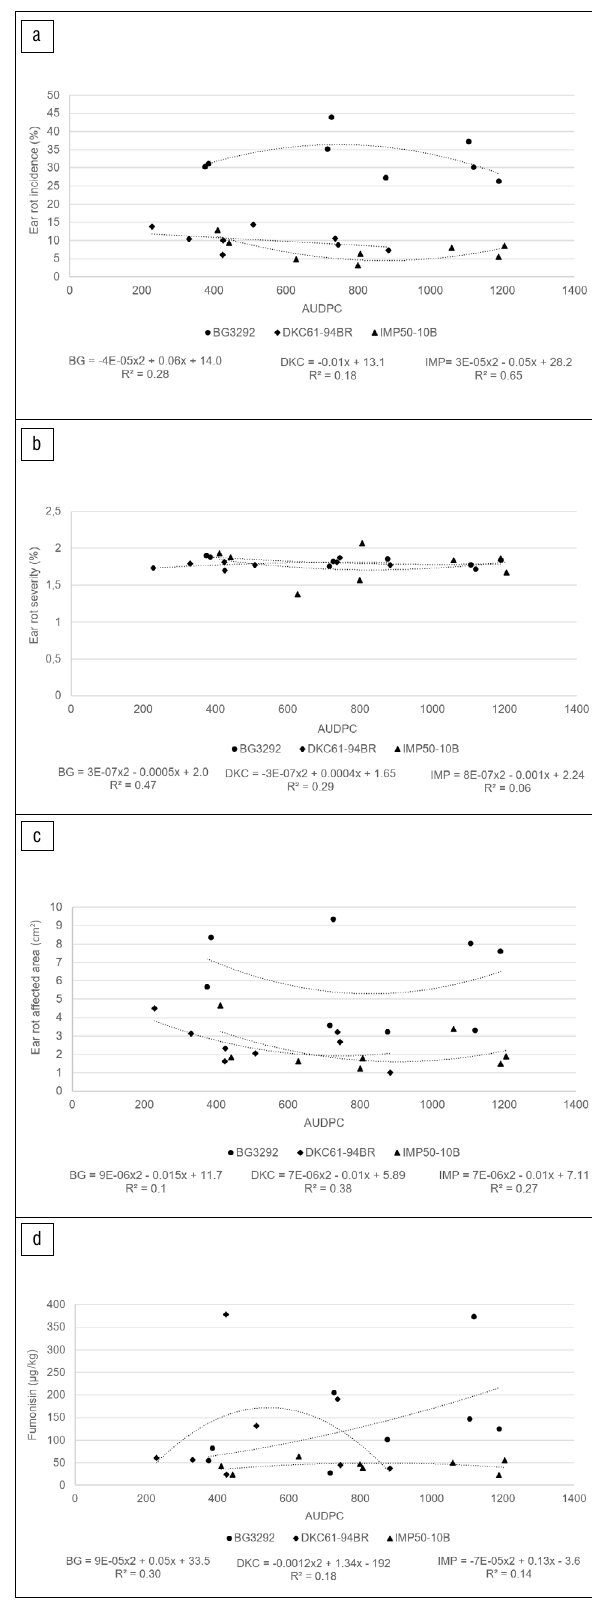
Figure 2: Average obtained over four trials for (a) ear rot incidence (%), (b) ear rot severity (%), (c) ear rot affected area (cm 2 ) and (d) fumonisin concentration (µg/kg) in the grain, regressed against area under the disease progress curve (AUDPC) achieved at dent stage of eight applied